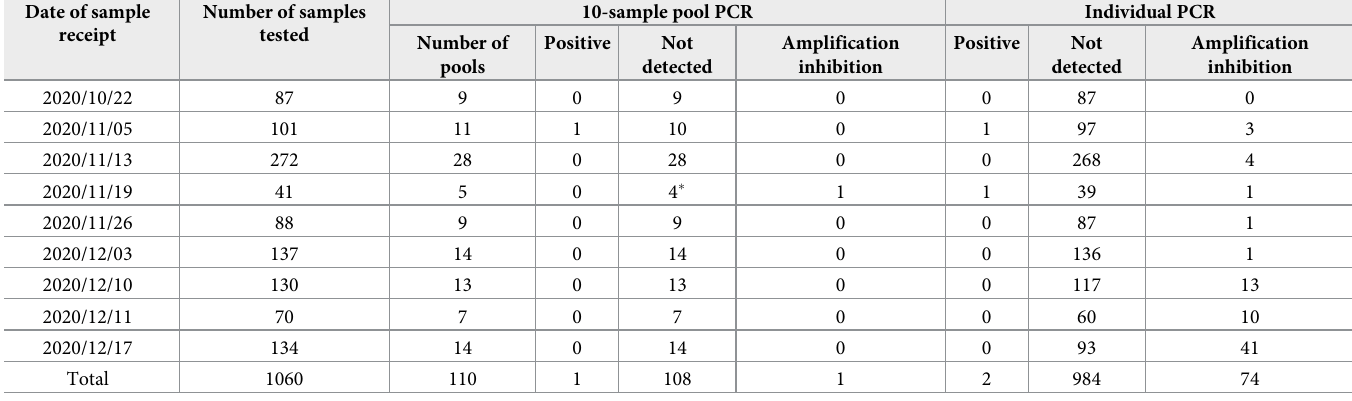
Table 3. Pooled and individual